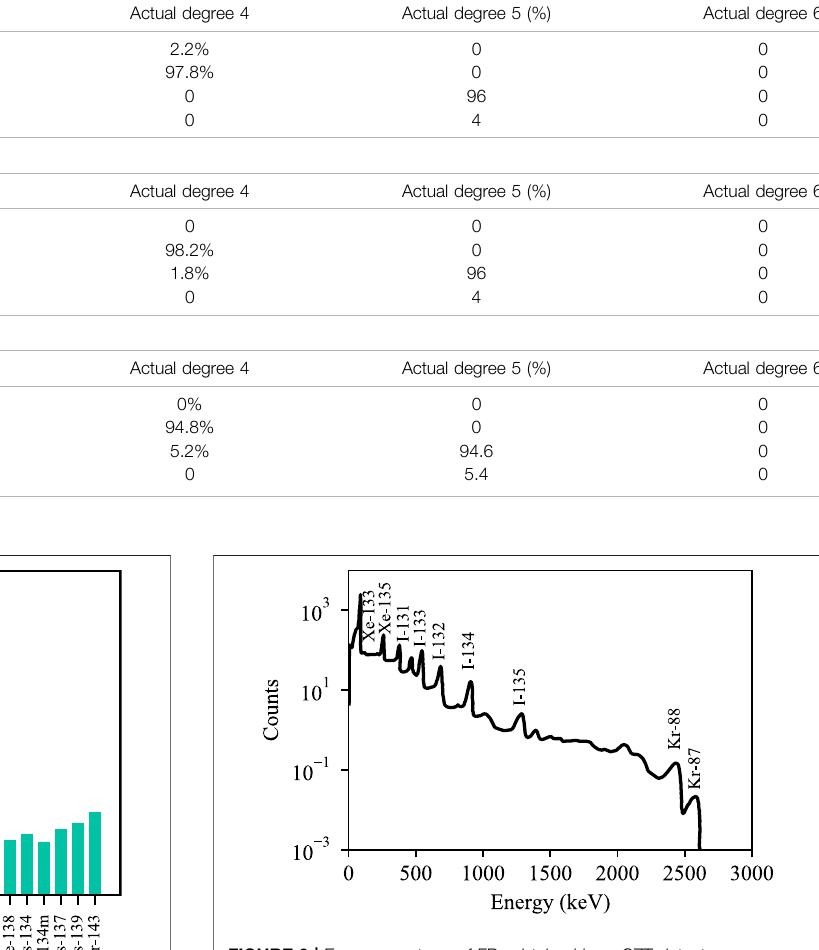
FIGURE 9 | Energy spectrum of FPs obtained by a CZT